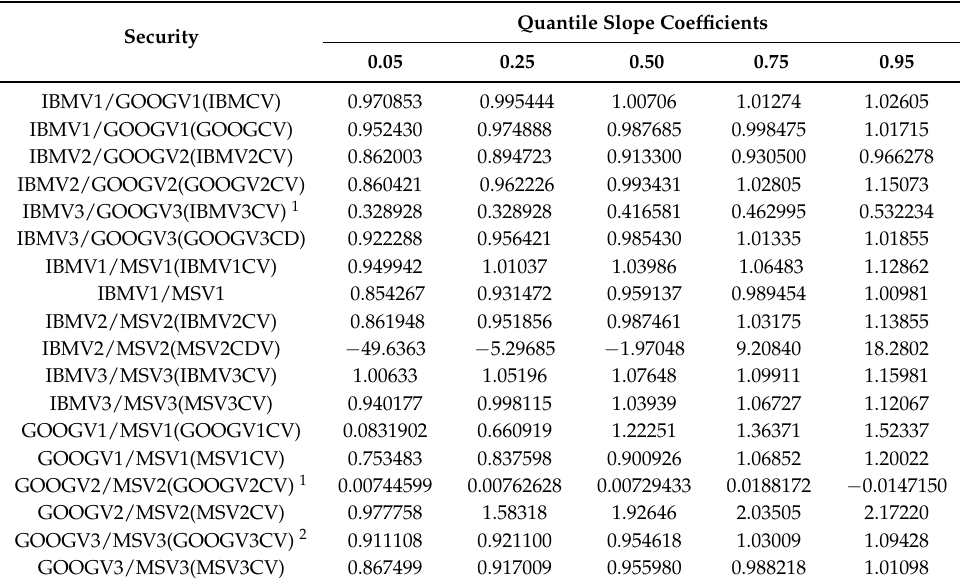
Table 9. Quantile regression of predicted conditional variances for Full